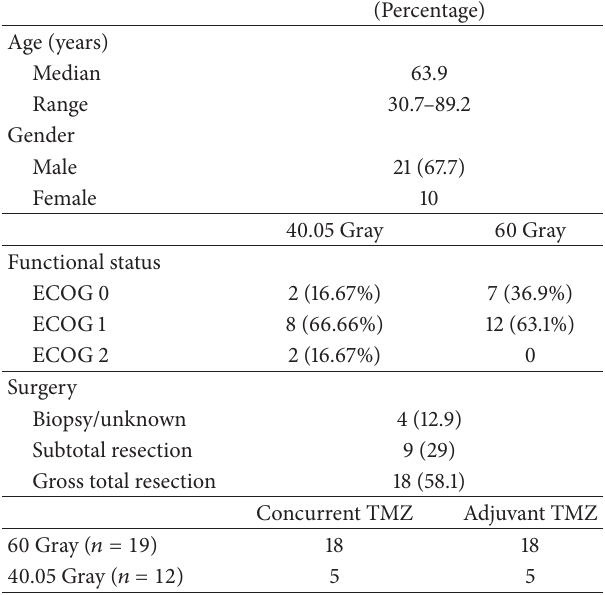
Table 1: Patient